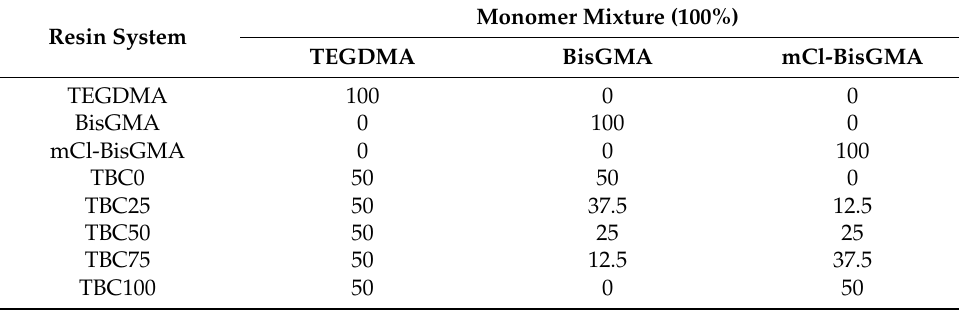
Table 1. Compositions of the experimental